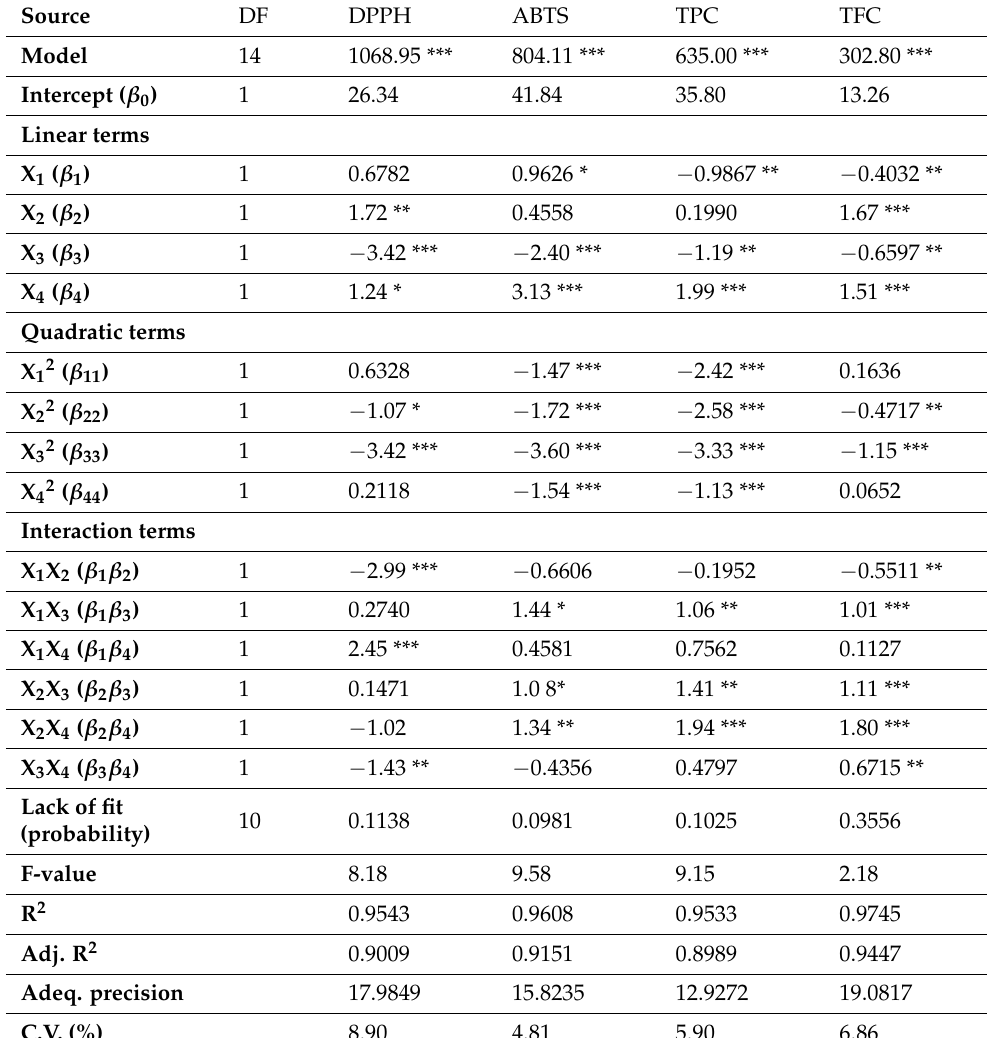
Table 2. ANVOA analysis for well-fitted RSM